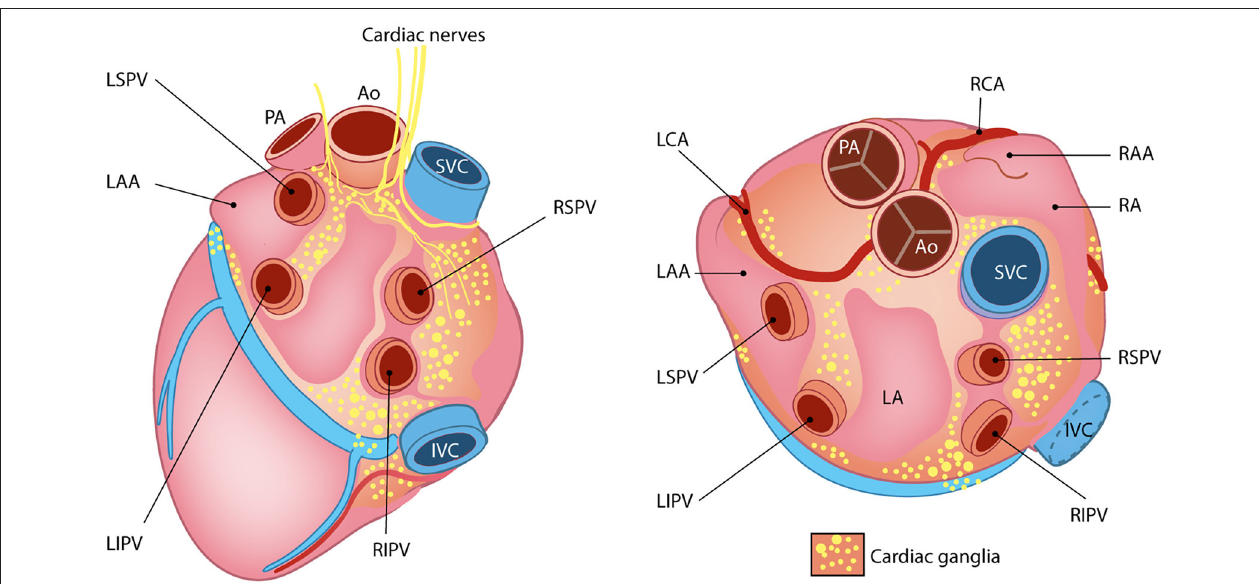
FIGURE 11 | The little heart brain. Schematic representation of cardiac intrinsic ganglia. Ao, aorta; PA, pulmonary artery; LAA, left atrial appendage; LCA, left coronary artery; LIPV, left inferior pulmonary vein; LSPV, left superior pulmonary vein; RAA, right atrial appendage; RCA, right coronary artery; RIPV, right inferior pulmonary vein; RSPV, right superior pulmonary vein. Modified with permission from Wink et al.